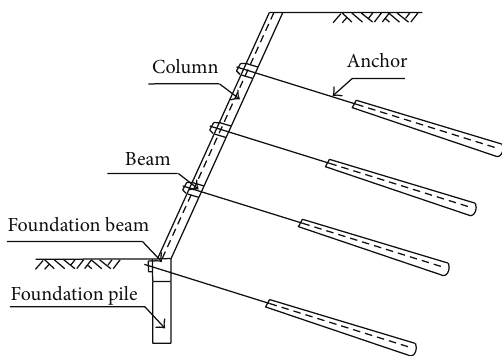
Figure 1: Sectional sketch of grillage supporting structure with prestressed anchor.